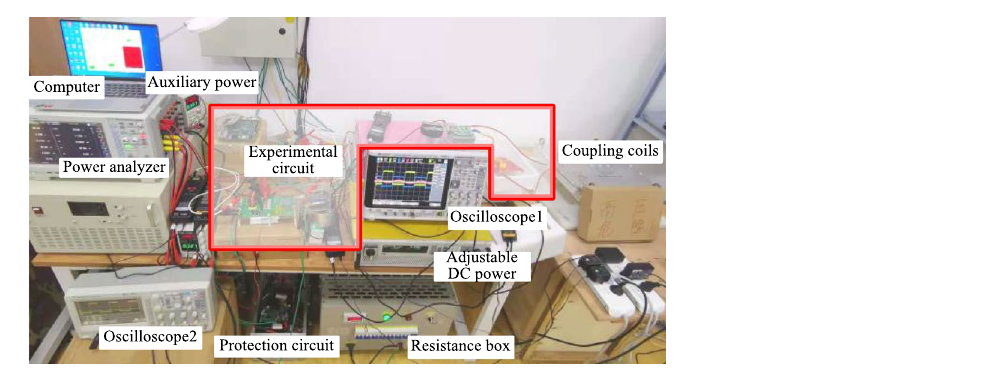
Figure 16. Experimental